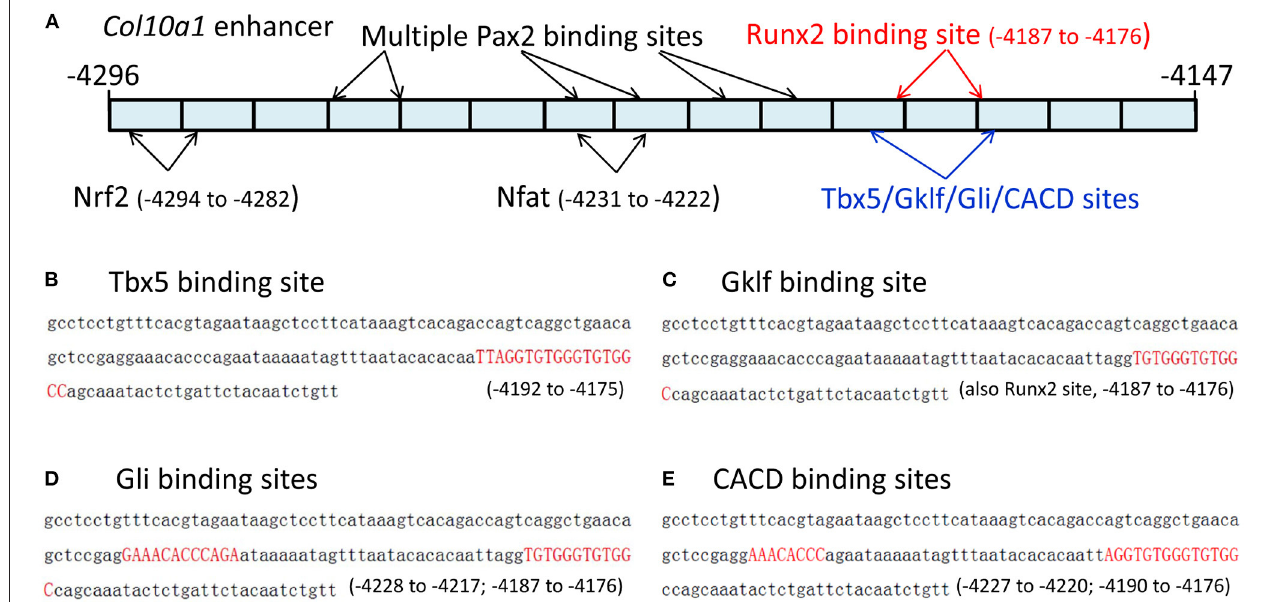
FIGURE 1 | The 150-bp Col10a1 cis-enhancer and its binding sites for selected candidate TFs. (A) Schematic illustration of the cis-enhancer derived from the Col10a1 distal promoter region ( − 4,296 to − 4,147 bp). Positions of putative binding sites for Pax2, Nrf2, Nfat, Tbx5, Gklf, Gli, CACD, and Runx2 are shown. (B–E) Sequences of predicted binding sites for Tbx5, Gklf, Gli, and CACD are highlighted in red. These TFBSs are the same as or overlap with the previously described Runx2 binding site TGTGGGTGTGGC ( − 4,187 to − 4,176 bp) (Li et al.,